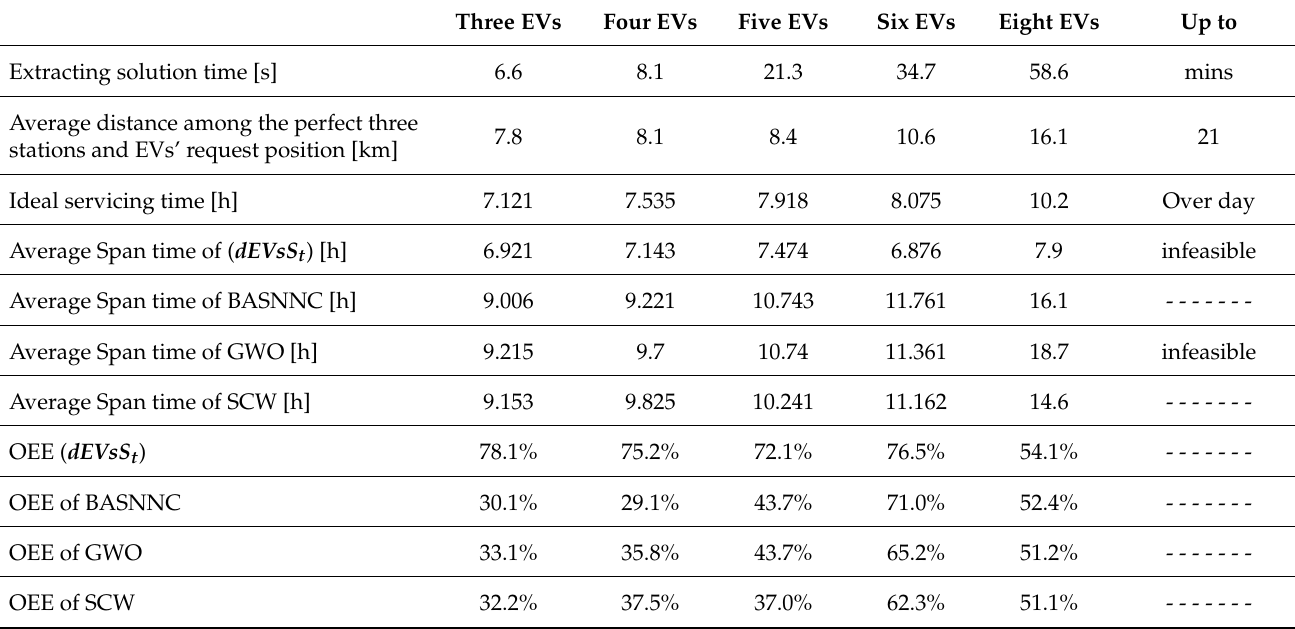
Table 10. The comparative average of thirty examples for four different problem sizes. Three EVs Four EVs Five